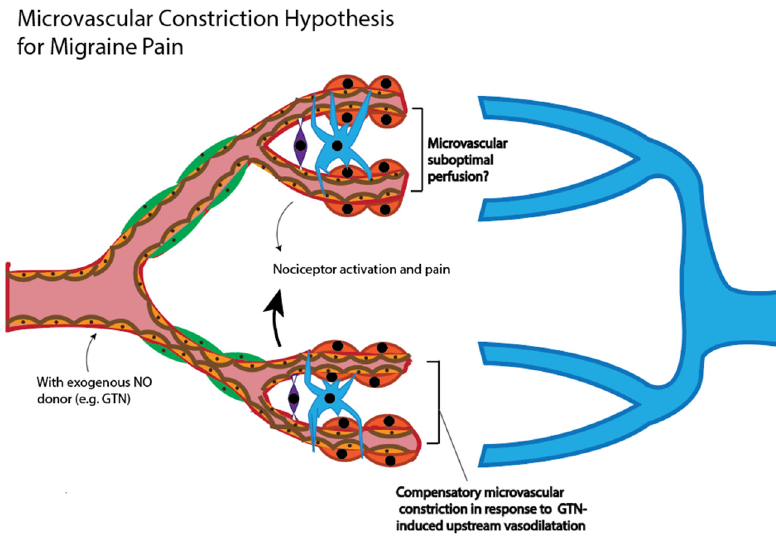
Figure 3. Alternate hypothesis for vascular changes in migraine. Stress-induced heightened sympathetic tone results in a chronically constrictive microvascular phenotype, both centrally and within the periphery. Suboptimal central parenchymal blood flow (potential hypoxia) could activate nociceptors and cause headache pain onset. Traditional NO donors (such as GTN) principally modulate upstream larger central arteries, and would only exacerbate downstream vasoconstriction. Provision of eNOS inhibitors will reduce blood flow to the brain through larger arteries, requiring compensatory downstream dilatation of capillaries. The latter restores the provision of nutrients and oxygen.